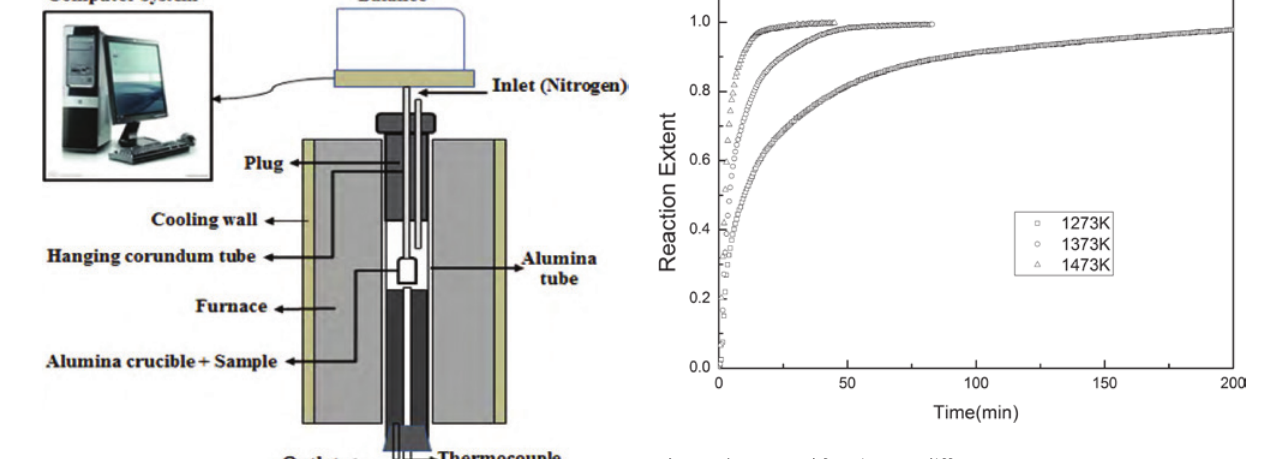
Fig. 2: The reacted fractions at different temperatures